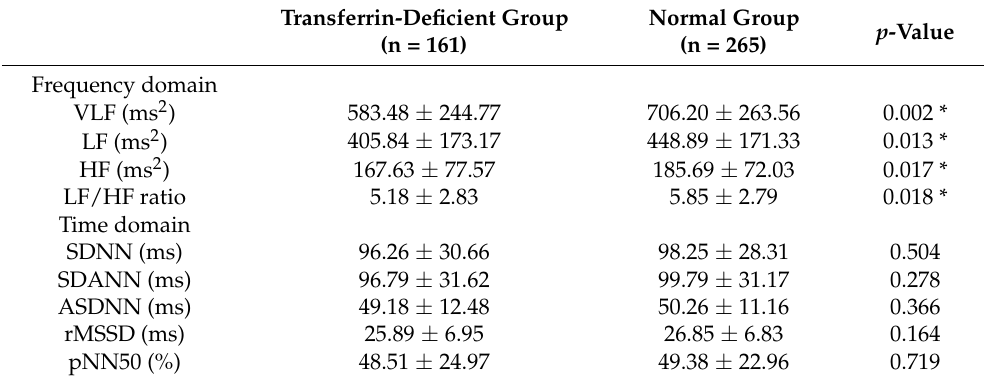
Table 4. Comparison of the HRV parameters among subgroups categorized by serum transferrin